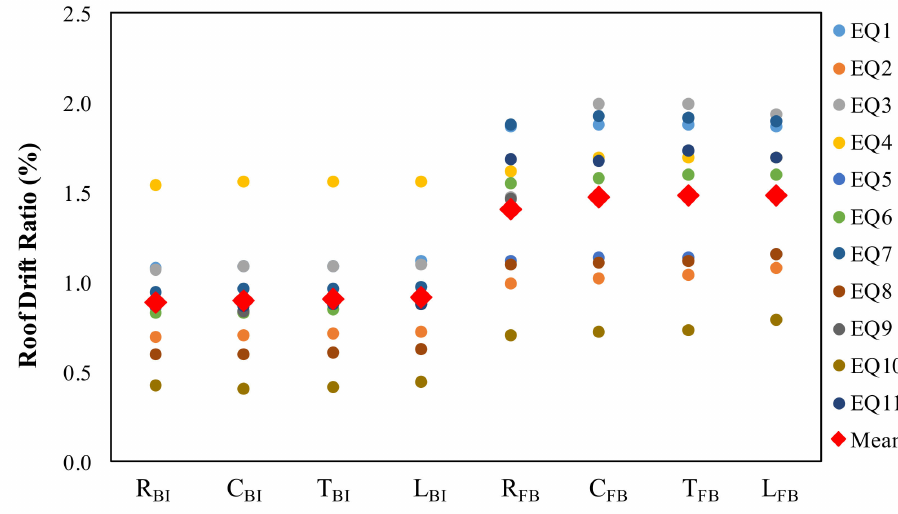
Figure 18. Roof drift ratio for isolated- and fixed-base R, C, T, and L